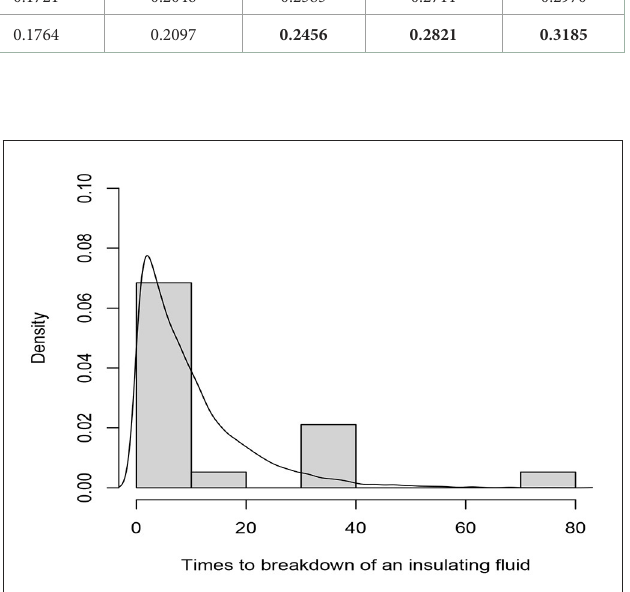
FIGURE3 Histogram of the complete data and fitted exponential pdf curve of the data in Table 6.